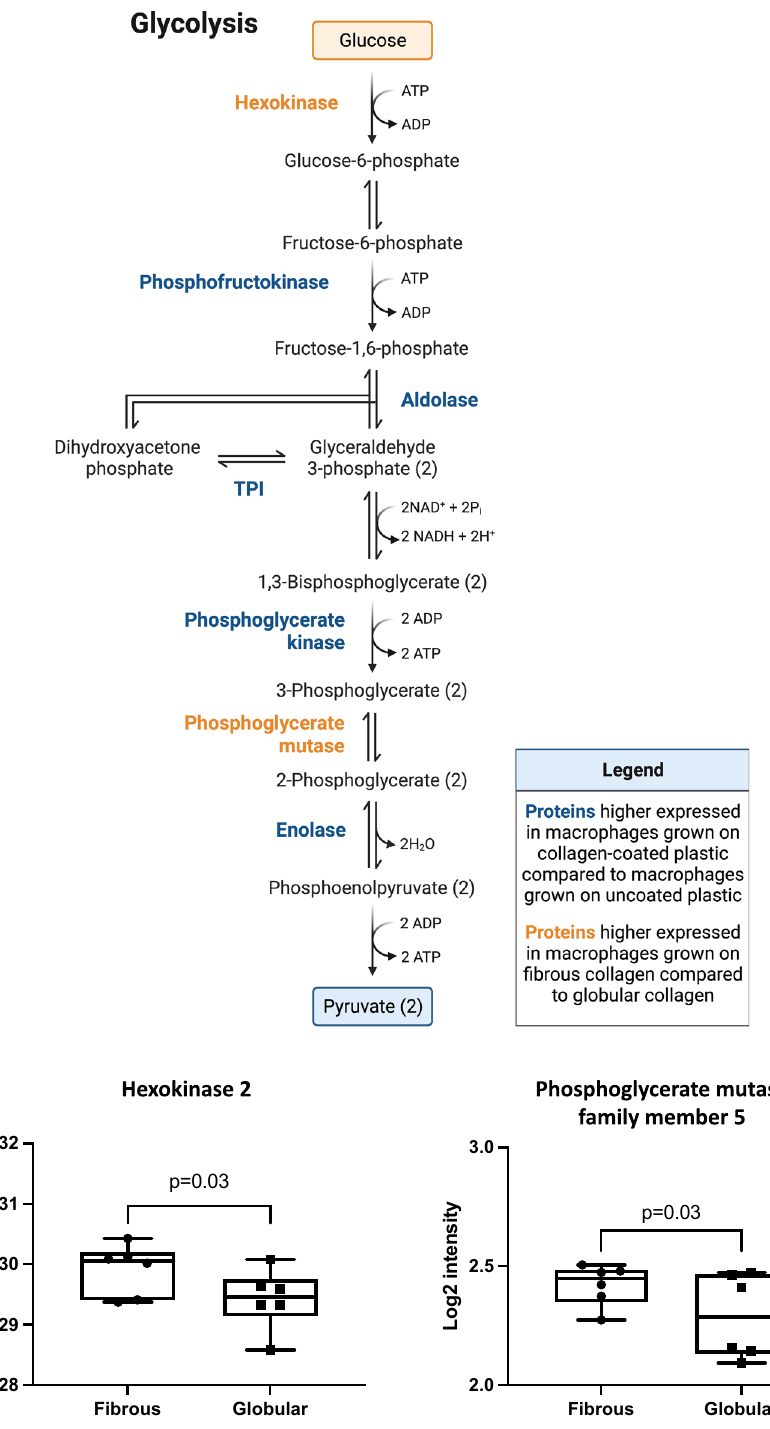
Figure 3. Glycolytic enzymes that were differentially expressed between macrophages cultured on fibrous or globular collagen. ( a ) Glycolysis metabolic pathway. Five proteins of the glycolysis pathway were significantly higher expressed in macrophages grown on collagen-coated plastic (fibrous and globular pooled, n = 6 each) compared to macrophages grown on uncoated plastic are indicated in blue. Proteins of the glycolysis pathway that were significantly higher expressed in macrophages grown on fibrous collagen compared to globular collagen are indicated in orange (fold change < 0.875 or > 1.25). ( b ) Two proteins of the glycolysis pathway were significantly higher expressed in macrophages grown on fibrous collagen compared to macrophages grown on globular collagen. Data are expressed as normalized Log2 values and statistically tested with a paired Wilcoxon test and p < 0.05 was considered significant (n = 6). Data represented as a box and whiskers plot, where the box extends from the 25th to 75th percentiles and whiskers from min to max